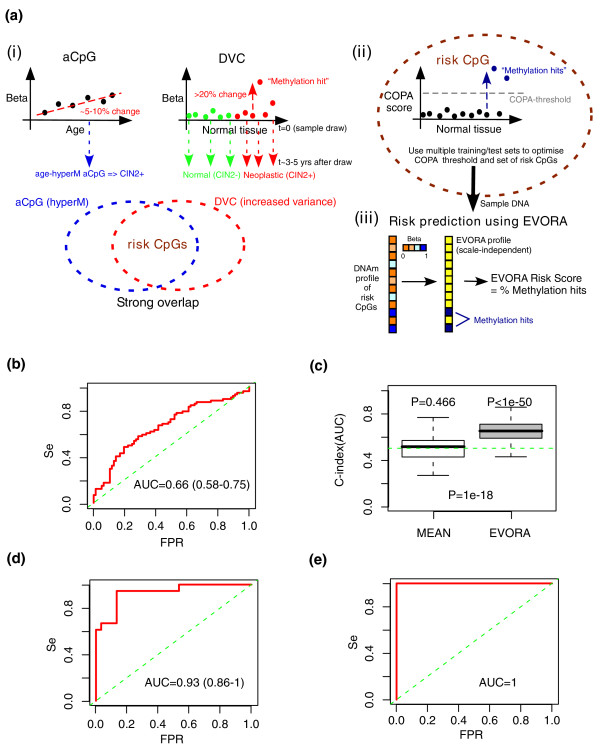
Epigenetic variable outliers for risk prediction analysis. (a) Flowchart describing the EVORA model. (i) Age-associated DNAm variation and age-independent differentially variable DNAm are both correlated with the risk of prospective neoplasia (CIN2+). aCpGs undergoing age-associated hypermethylation (hyperM) overlap strongly with differential variable CpGs (DVCs) that exhibit increased variance in future CIN2+ cases. This overlap defines, for a given training set, the pool of candidate risk CpGs. (ii) Multiple training/test set partitions in a ten-fold internal cross-validation on COPA-transformed (Methods) methylation profiles is used to optimize the COPA threshold and the set of risk CpGs. (iii) Risk prediction using EVORA: for an independent sample its risk score is estimated as the fraction of risk CpGs with a β-value larger than the optimal threshold, as evaluated in the COPA-basis. (b) EVORA receiver operating characteristic (ROC) curve, AUC and its 95% confidence interval in the ARTISTIC cohort (152 normal samples: 75 future CIN2+, 77 normals). (c) Comparison of C-index (AUC) values obtained using EVORA with a classification algorithm based on detecting differences in mean methylation levels (mean) in the ARTISTIC cohort. Boxplots are over 100 distinct training-test set partitions and P-values are from a Wilcoxon test detecting deviation from the expected null (C-index = 0.5) as well as between the two classification algorithms. (d) EVORA ROC curve in set 1 (48 liquid-based cytology samples: 18 CIN2+, 30 normals). (e) EVORA ROC curve in set 2 (63 cervical tissue samples: 48 cancers, 15 normals). In all ROC curves, AUC values and 95% confidence intervals shown. FPR: false positive rate; Se: sensitivity.